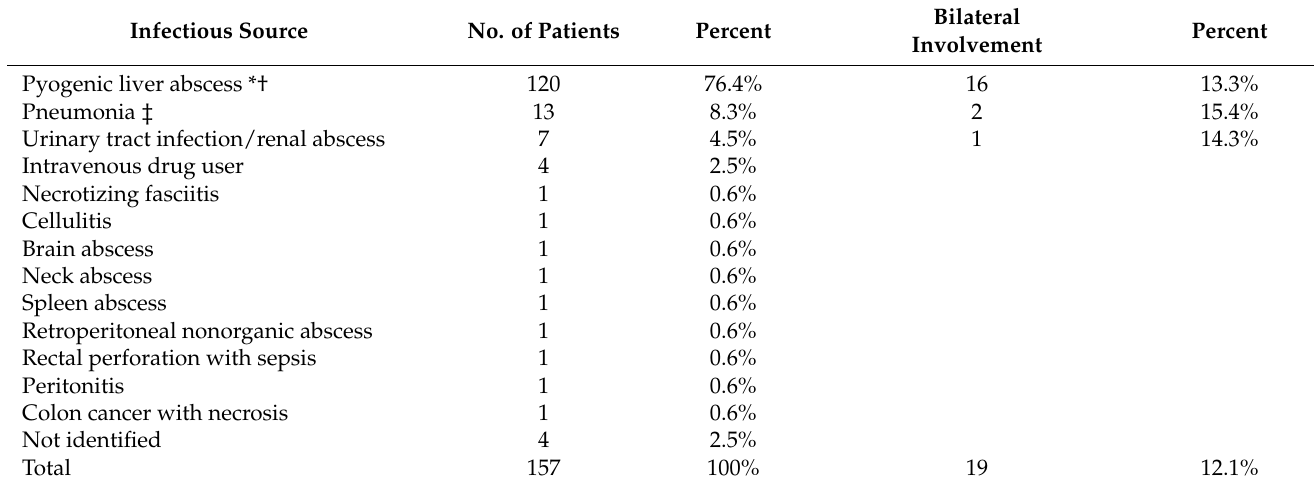
Table 1. Infection sources of endogenous Klebsiella pneumoniae endophthalmitis.